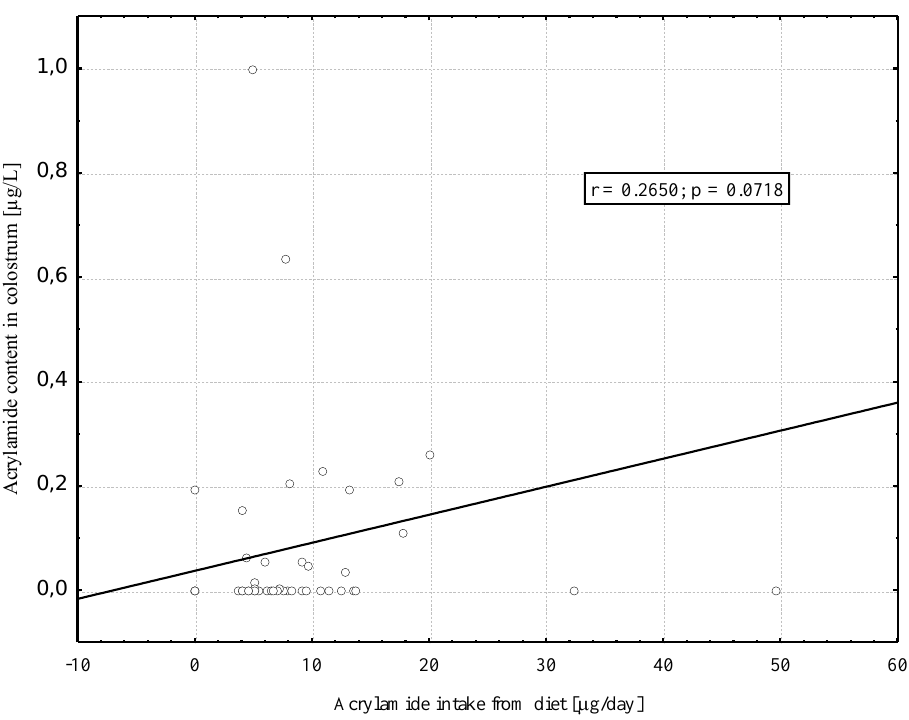
Figure 3. Correlation between the acrylamide intake from diet by the breastfeeding women and the acrylamide in their colostrum.